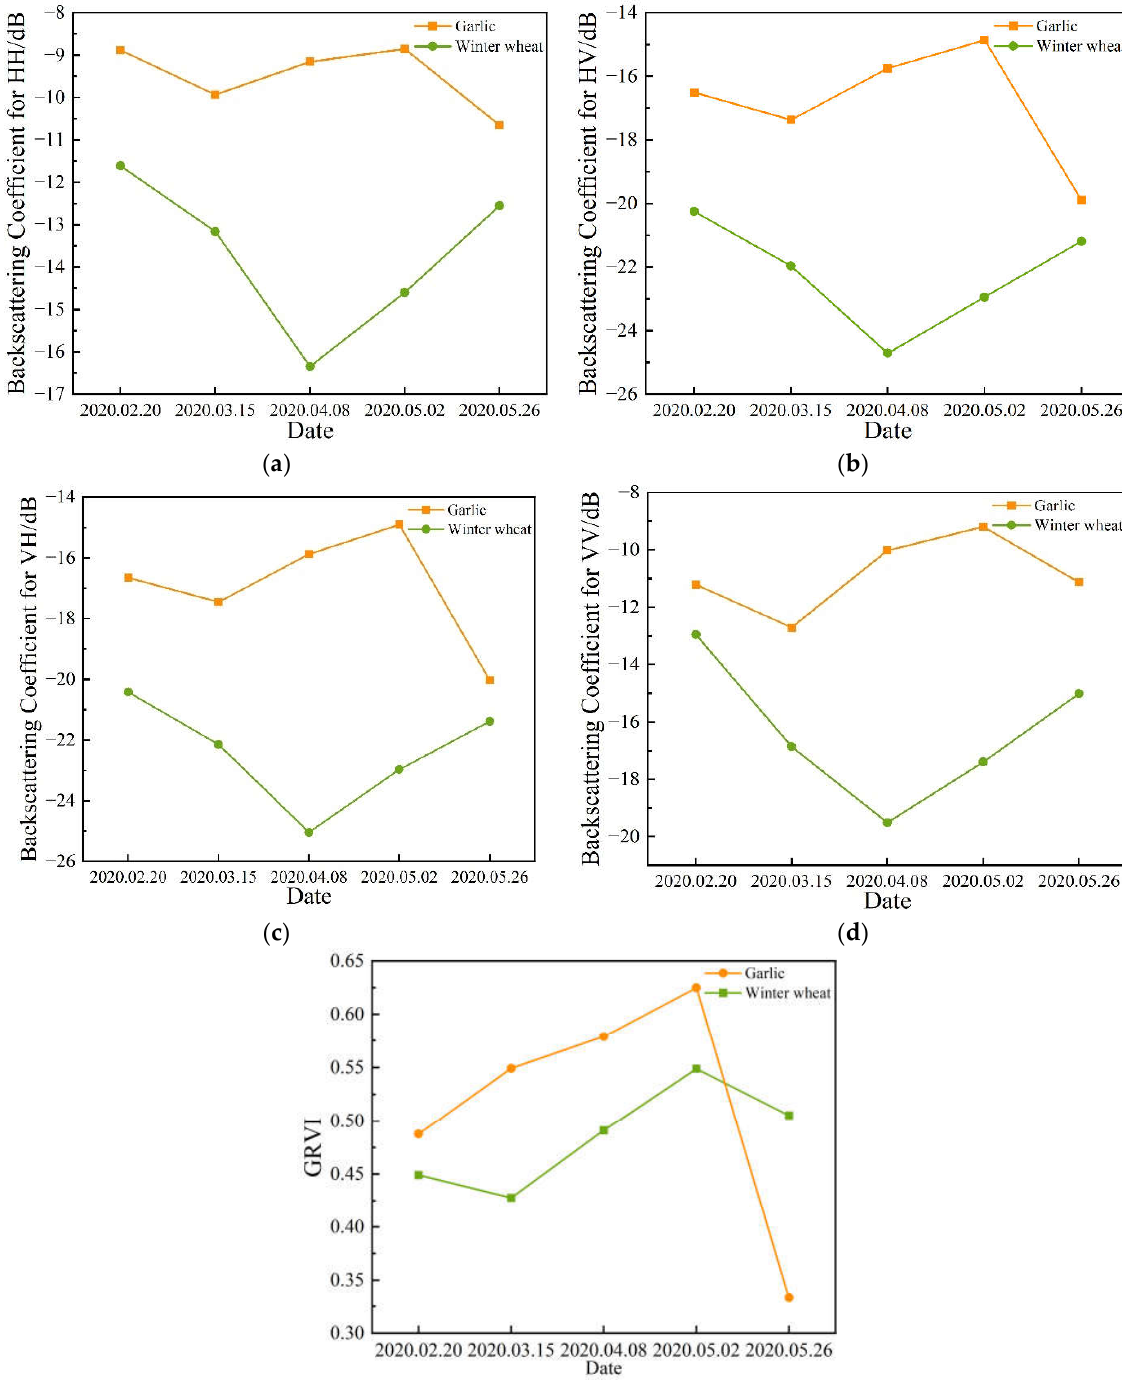
Figure 5. Temporal profiles of the two different crop types with respect to the backscatter coefficient: to GRVI.